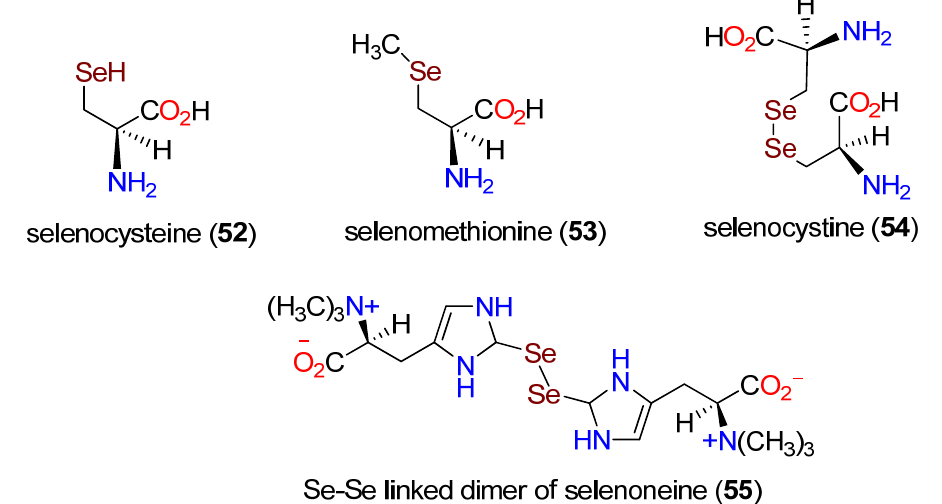
Figure 18. Structures of selenocysteine ( 52 ), selenomethionine ( 53 ), selenocystine ( 54 ), and the Se-Se-linked dimer of selenoneine ( 55 ).